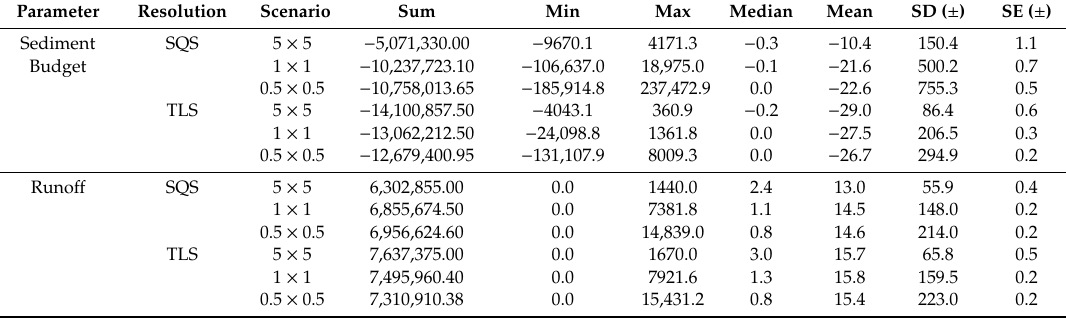
Table 2. Central statistics for runo ff (m 3 ) and sediment budget (kg m − 2 ) summarized for all three fields for the Status-Quo (SQS) and Tramline-Scenario (TLS) for di ff erent spatial resolutions.